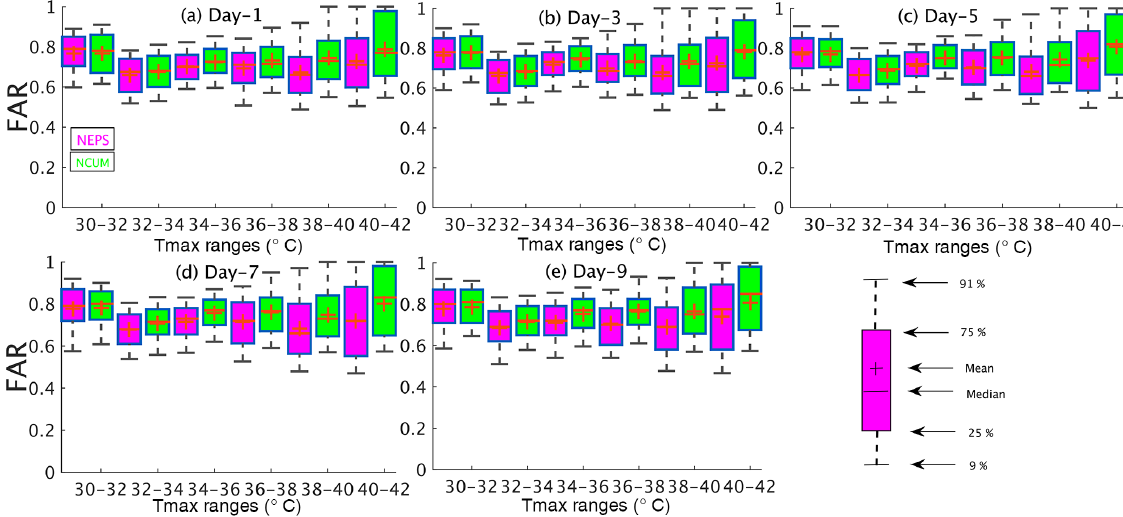
Figure 11. Box plots (a–e) for false alarm ratio (FAR) for NCUM and NEPS from March to May 2016 (NCUM stands for NCMRWF unified model and NEPS stands for NCMRWF ensemble prediction system). FAR values are lower in NEPS forecasts, particularly at high temperature ranges (>36 ◦ C), and for all lead times compared to NCUM forecasts, suggesting improved performance of NEPS at higher temperature